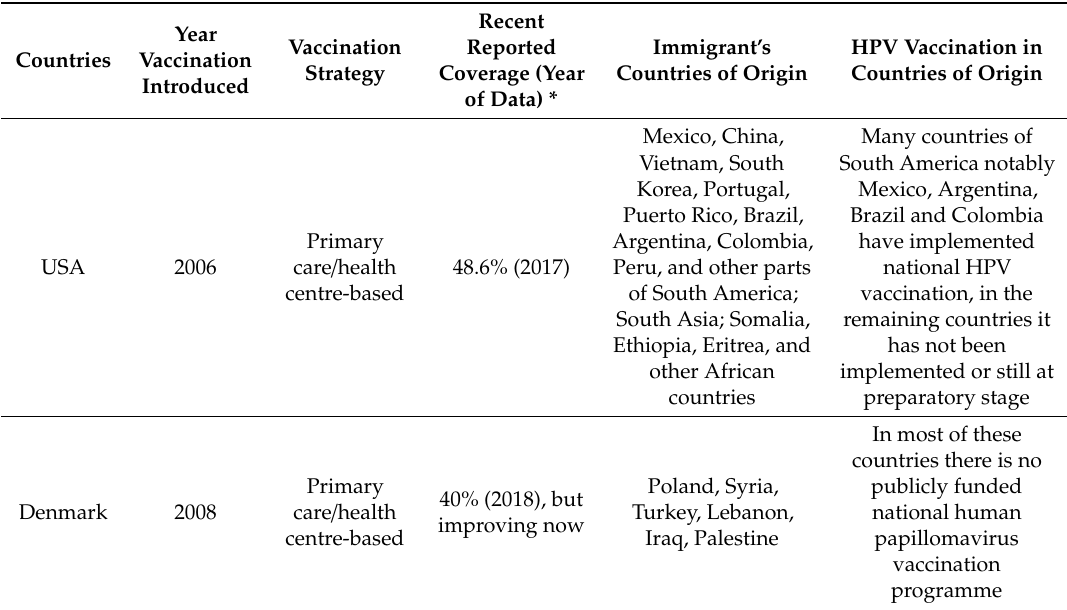
Table 1. Human papillomavirus (HPV) vaccination programs in several countries that receive high numbers of immigrants from developing